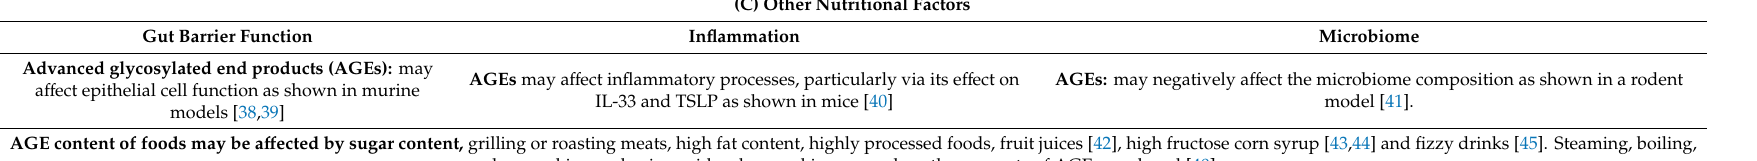
(C) Other Nutritional